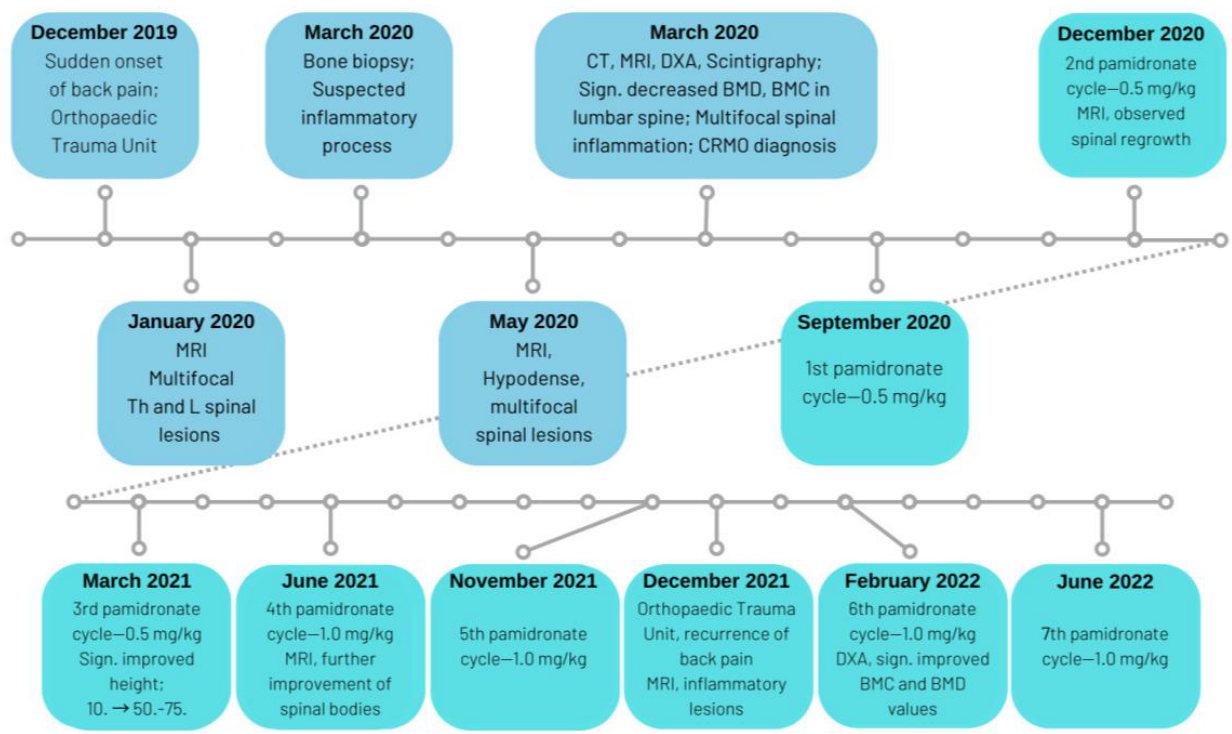
Figure 1. The timeline of patient’s diagnostics and treatment .